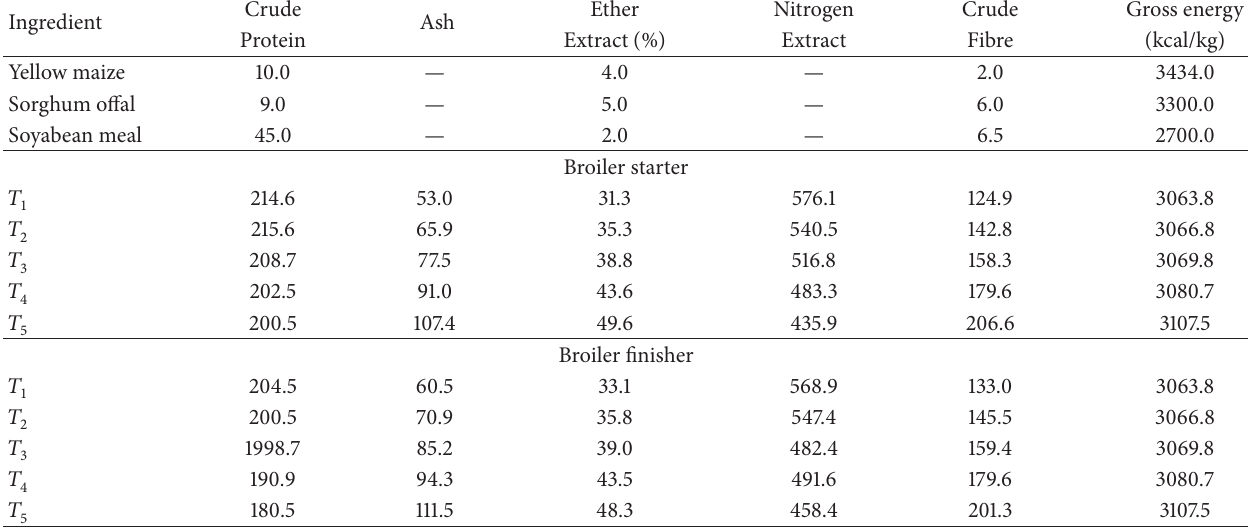
Table 3: Nutrients composition of the ingredients and their costs.